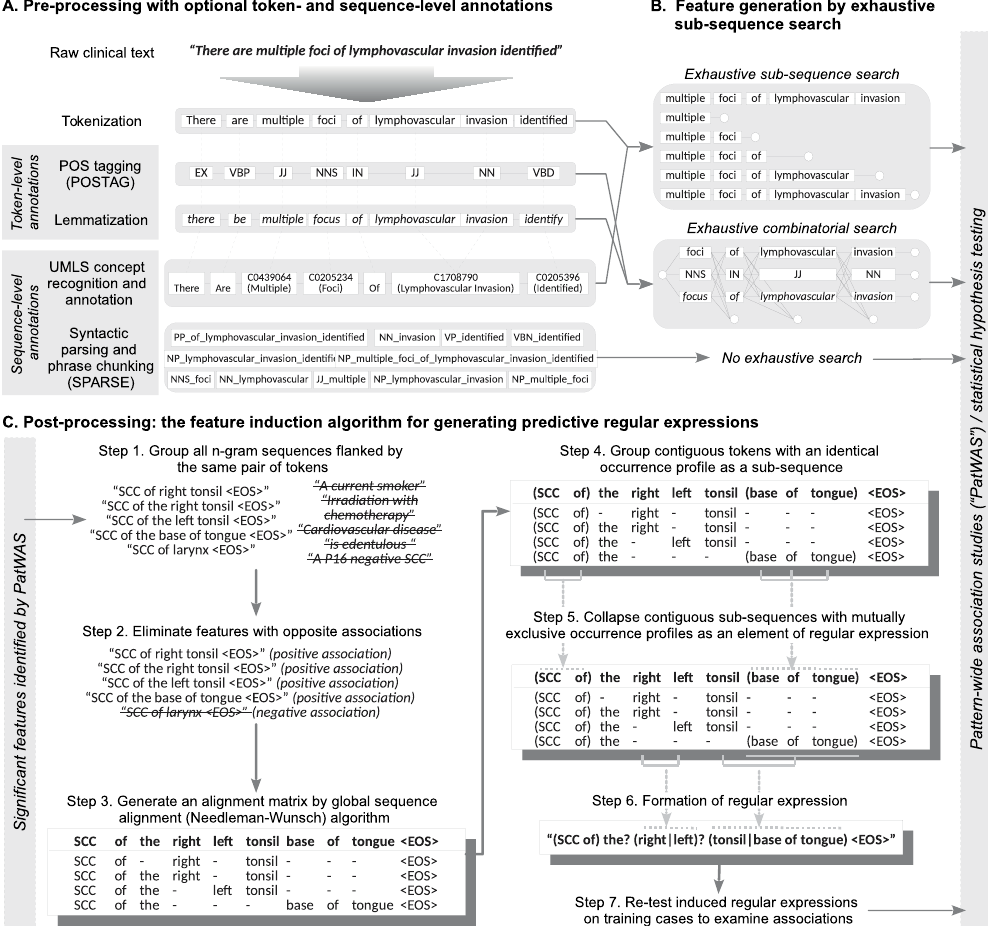
Figure 2. Illustrated methods of annotation, sub-sequence search, and regular expression induction. EMR narratives are tokenized, annotated, and transformed into text fragments (n-gram) prior to association testing. Syntactically similar n-grams are then (optionally) grouped into regular expressions with the aim to aggregate conceptually similar features improve overall